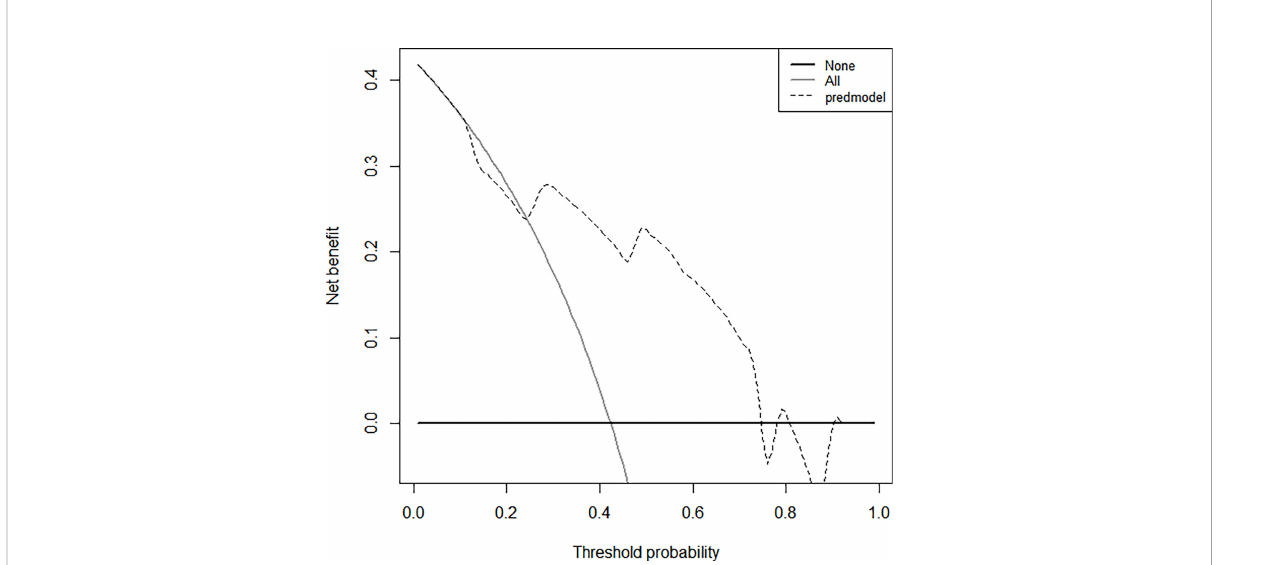
FIGURE 6 The clinical values of this nomogram model for decision curve analyses (DCA). The Y-axis represents the net bene fi t. The dotted line represents the clinicopathologic nomogram. The gray line represents the hypothesis that all patients are involved in HGG. The black solid line represents the hypothesis that no patients are involved in HGG. The X-axis represents the HGG possibility